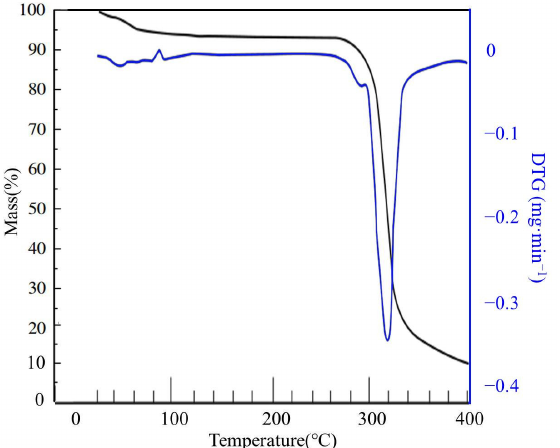
Figure 4. The TG and DTG curves of starch.